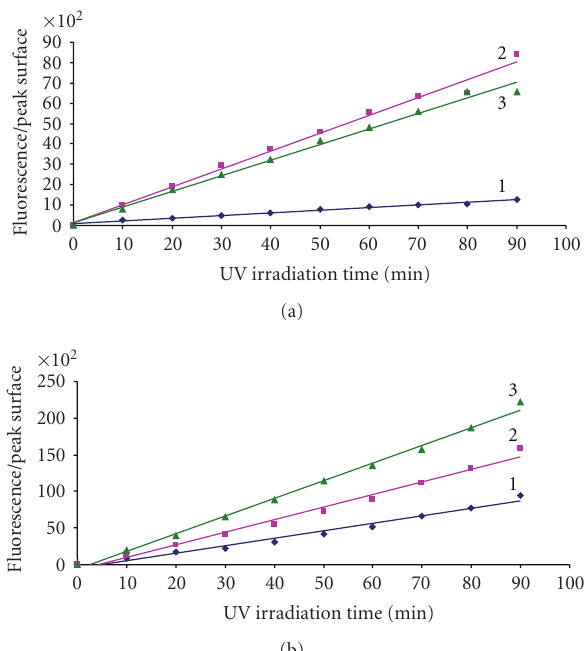
Figure 3: OH radicals formation on the photocatalyst surface by the fluorescence measurements of 7-hydroxycoumarine for (a) TiO 2 and (b) TiO 2 -WO 3 -3%; (1) as received, (2) 400 ◦ C-treated, and (3) 600 ◦ C-treated.